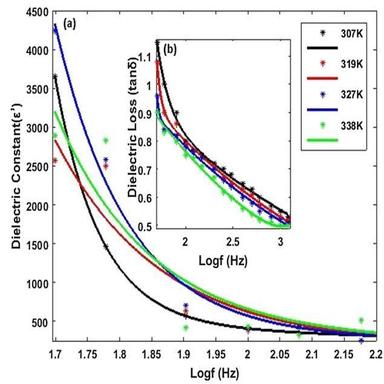
Plot of logarithm of frequency versus dielectric constant of PCOH at different temperatures.